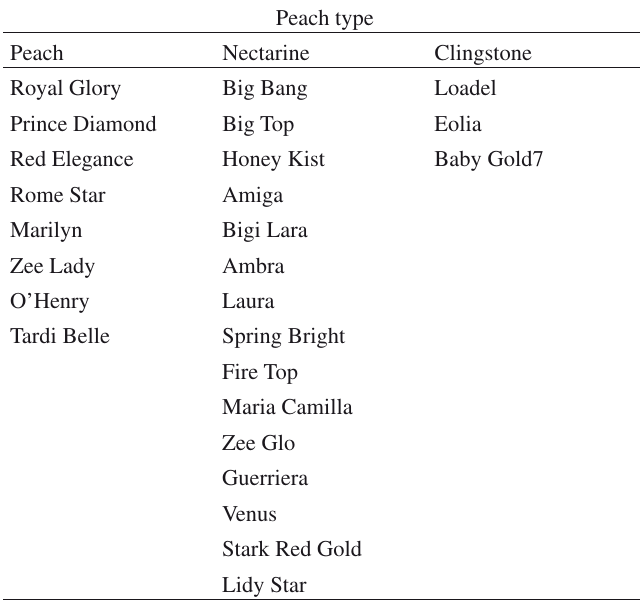
Table 1 - Peach varieties grouped in Peach, Nectarine and